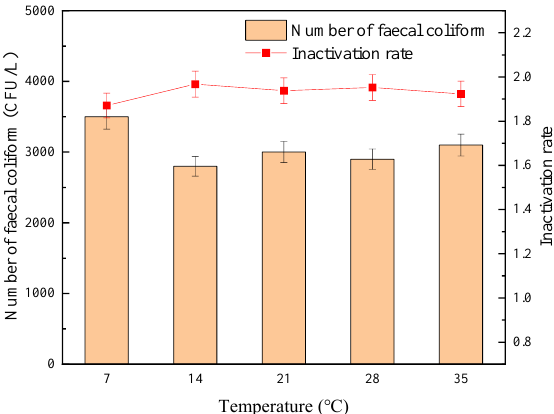
Figure 10. The effect of temperature on the sterilization effect of “ Method A ” .